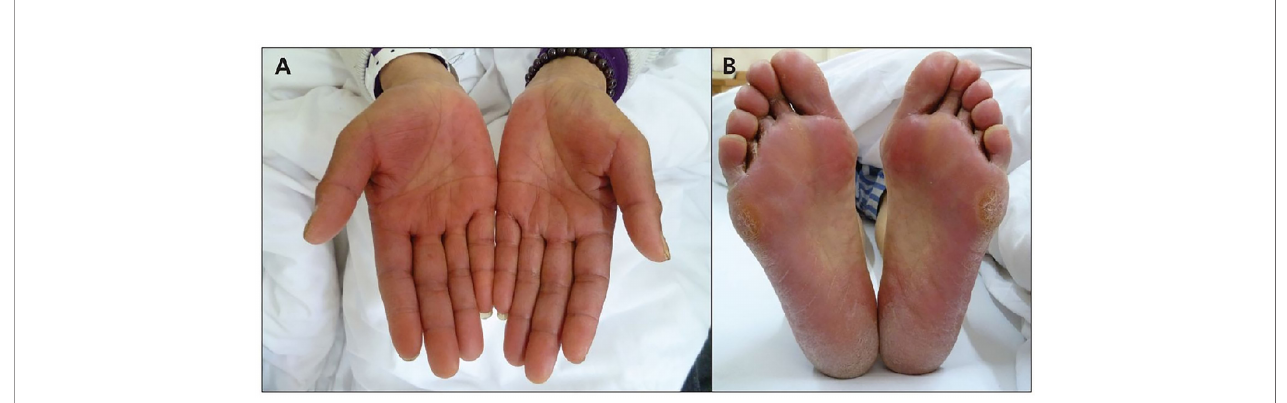
FIGURE 2 | Palma-plantar erythodysesthesia in a patient treated with sorafenib. (A) hand syndrome, (B) plantar